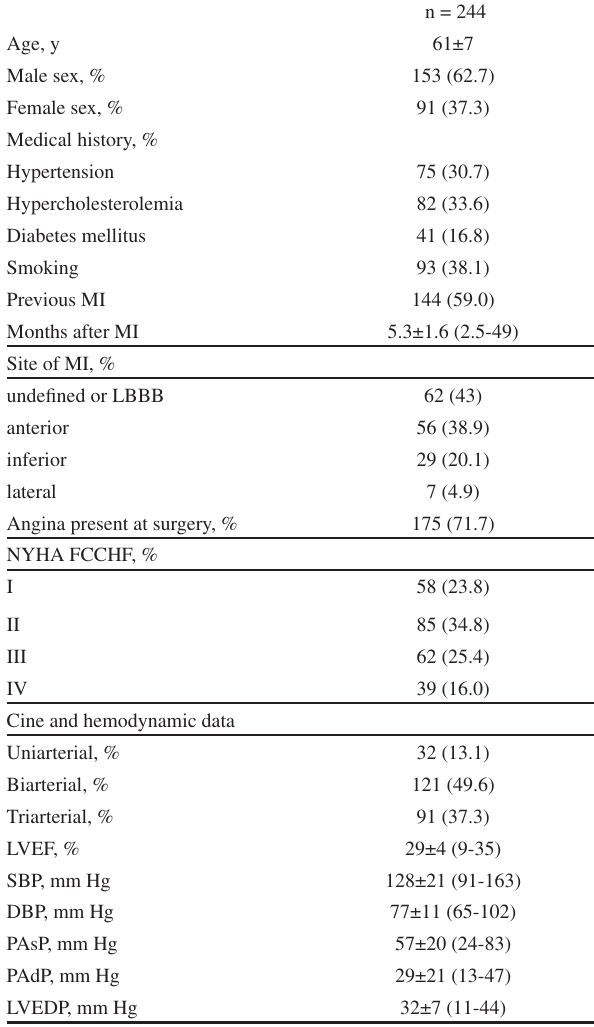
Table 3 - Morbidity according to preoperative